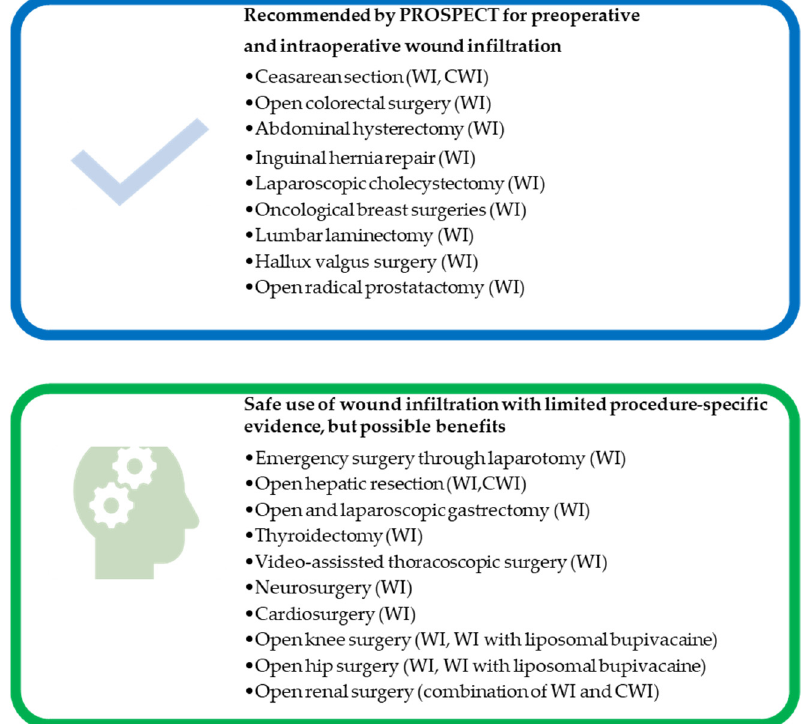
Figure 1. Summary of wound infiltration (WI) application in the preoperative and intraoperative period. European Society of Regional Anesthesia procedure-specific postoperative pain management (PROSPECT) working group recommended WI as part of multimodal pain management for several types of surgical procedures. Published studies suggest that WI is appropriate and safe when other techniques are contraindicated, but requires further investigation for efficiency in different kind of surgeries. WI ‐ wound infiltration; CWI ‐ continuous wound infiltration.